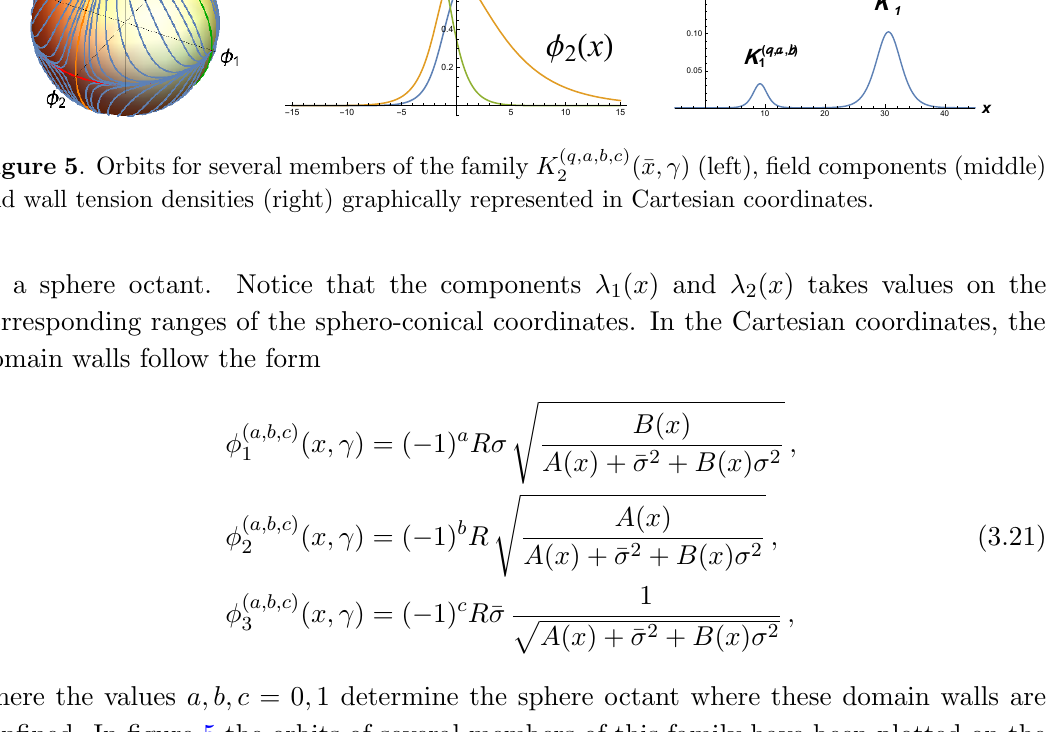
((cid:22) x; (cid:13) ) (left), (cid:12)eld components (middle) 2